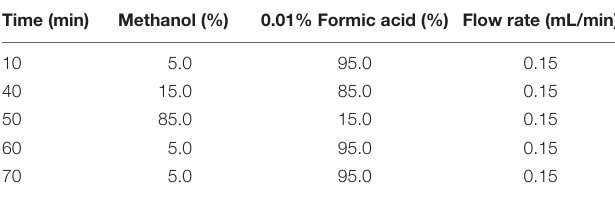
TABLE 1 | High-performance liquid chromatography (HPLC) gradient program used to separate